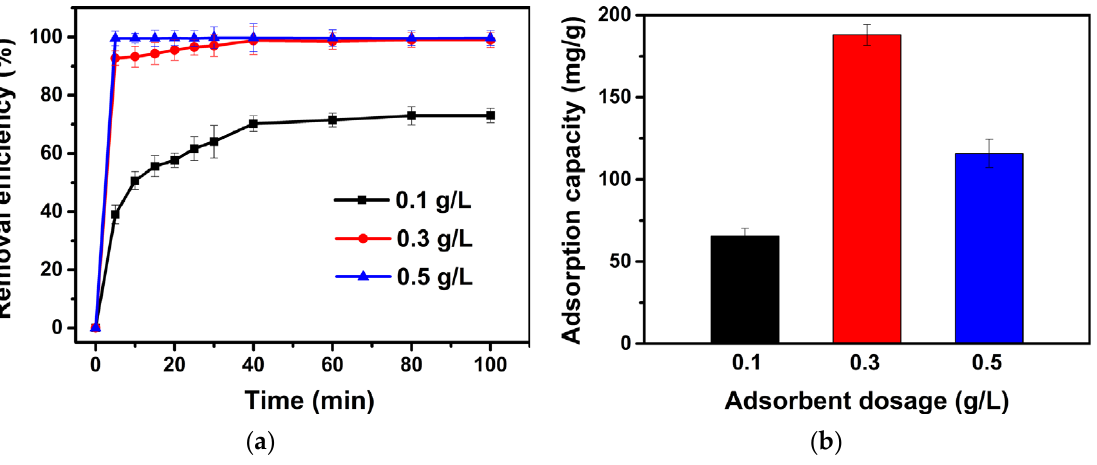
Figure 12. Effects of dosage of Sample SA-E on the removal efficiency ( a ) and adsorption capacity ( b ) of methylene blue.